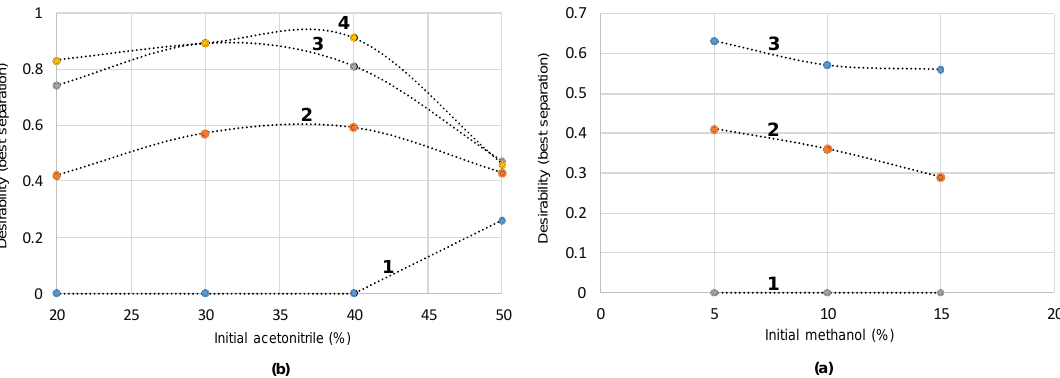
Figure 3. Optimization of the separation of phenolic compounds (method A) and curcuminoids (method B) by experimental design. ( a ) Phenolic compounds. Conditions of gradient time: 1 = 30 min; 2 = 40 min; 3 = 50 min. ( b ) Curcuminoids. Conditions of gradient time: 1 = 5 min; 2 = 10 min; 3 = 15 min; 4 = 20 min.